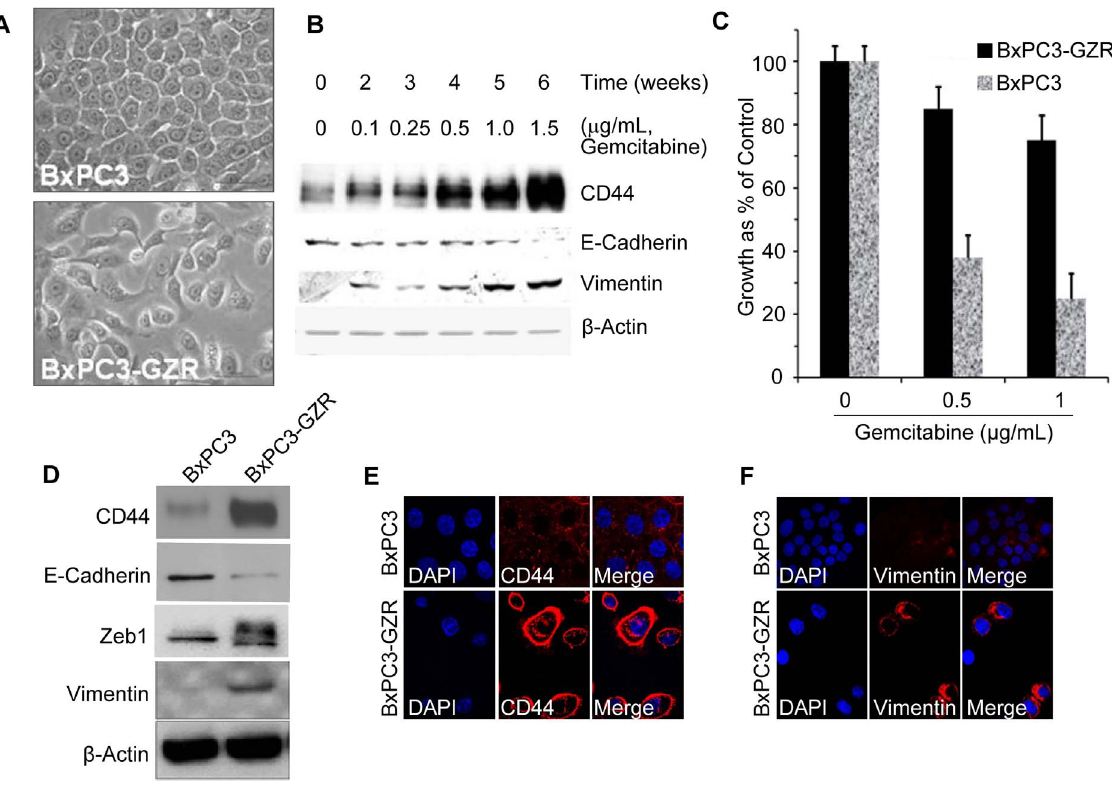
Figure 1. Characterization of BxPC3-GZR, a cell line model for CRMP. A. Morphological differences between parental BxPC3 and chemoresistance mesenchymal BxPC3-GZR cells. B. Western blot showing that BxPC3-GZR cells possess an EMT phenotype, which is demonstrated by increased expression of vimentin and a decrease of E-cadherin and express the stem cell marker CD44. C. MTT assay comparing the growth of the parental BxPC3 and BxPC3-GZR at 96 hrs after treatment with different concentrations of gemcitabine. D . Western blot comparing the expression of CD44, E-cadherin, Zeb-1 and vimentin after four passages of BxPC3 and BxPC3-GZR. E and F . Immunofluorescence confocal microscopy images show the differential expression of CD44 and vimentin in BxPC3 and BxPC3-GZR cells.